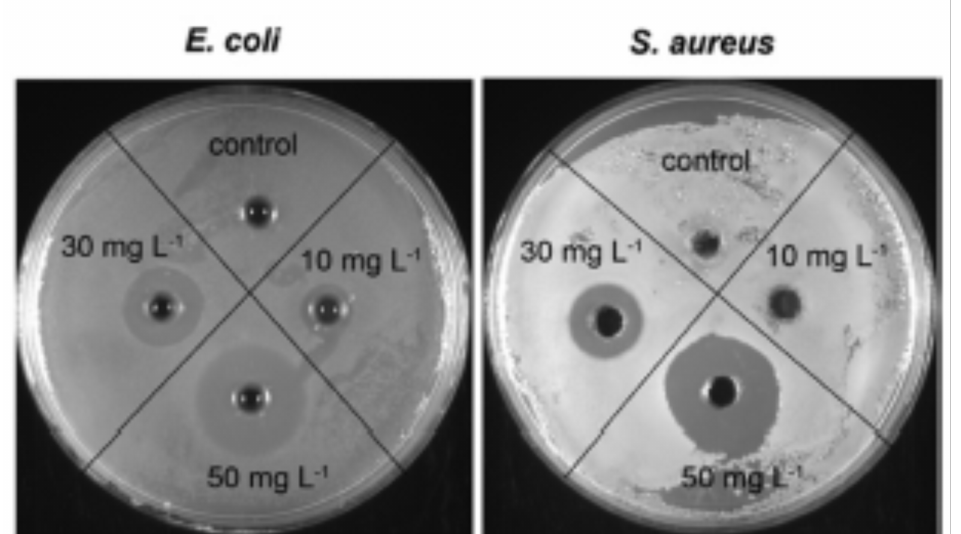
Figure 4. Photographs of E. coli and S. aureus grown around a series of concentrations of Ag/AgCl/rGO nanomaterials on the plates (adapted with permission from reference [63]).